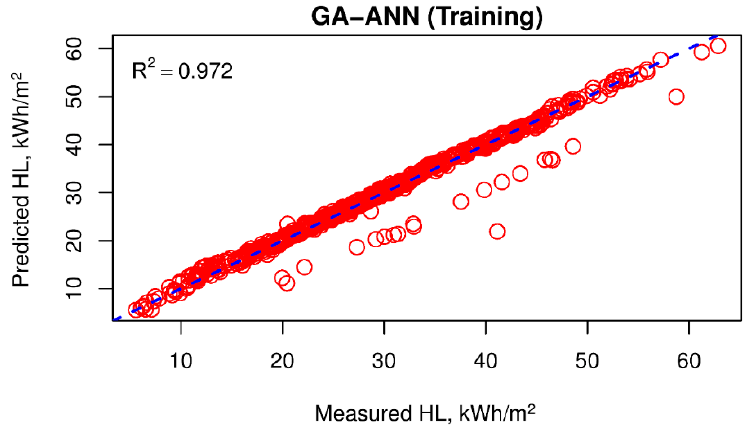
Figure 8. HL predictions on the training dataset of the GA-ANN model.